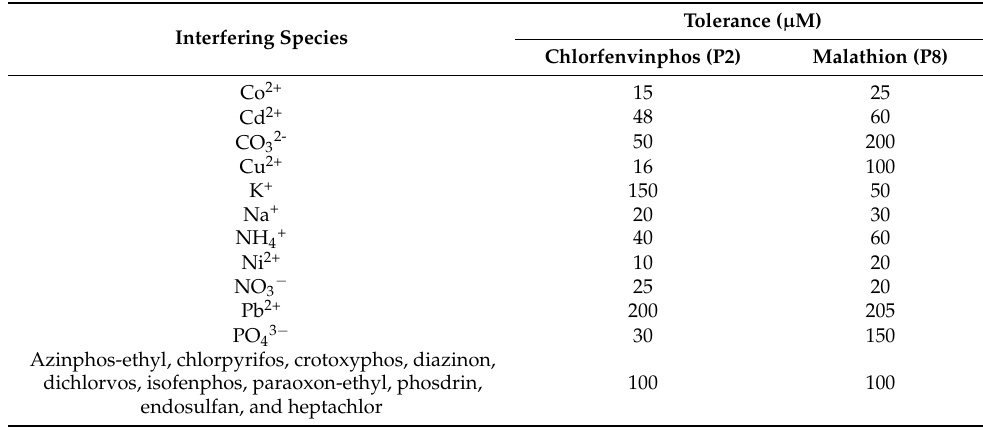
Table 5. The interference concentrations tolerated in the presence of 2.5 × 10 − 5 mol · L − 1 chlorfenvin- phos (P 2 ) and malathion